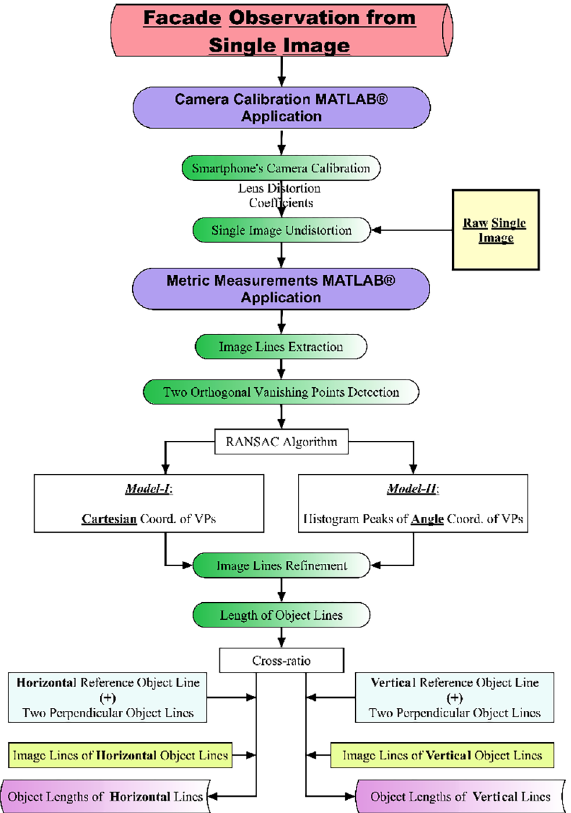
Figure 2. Flowchart for research methodology